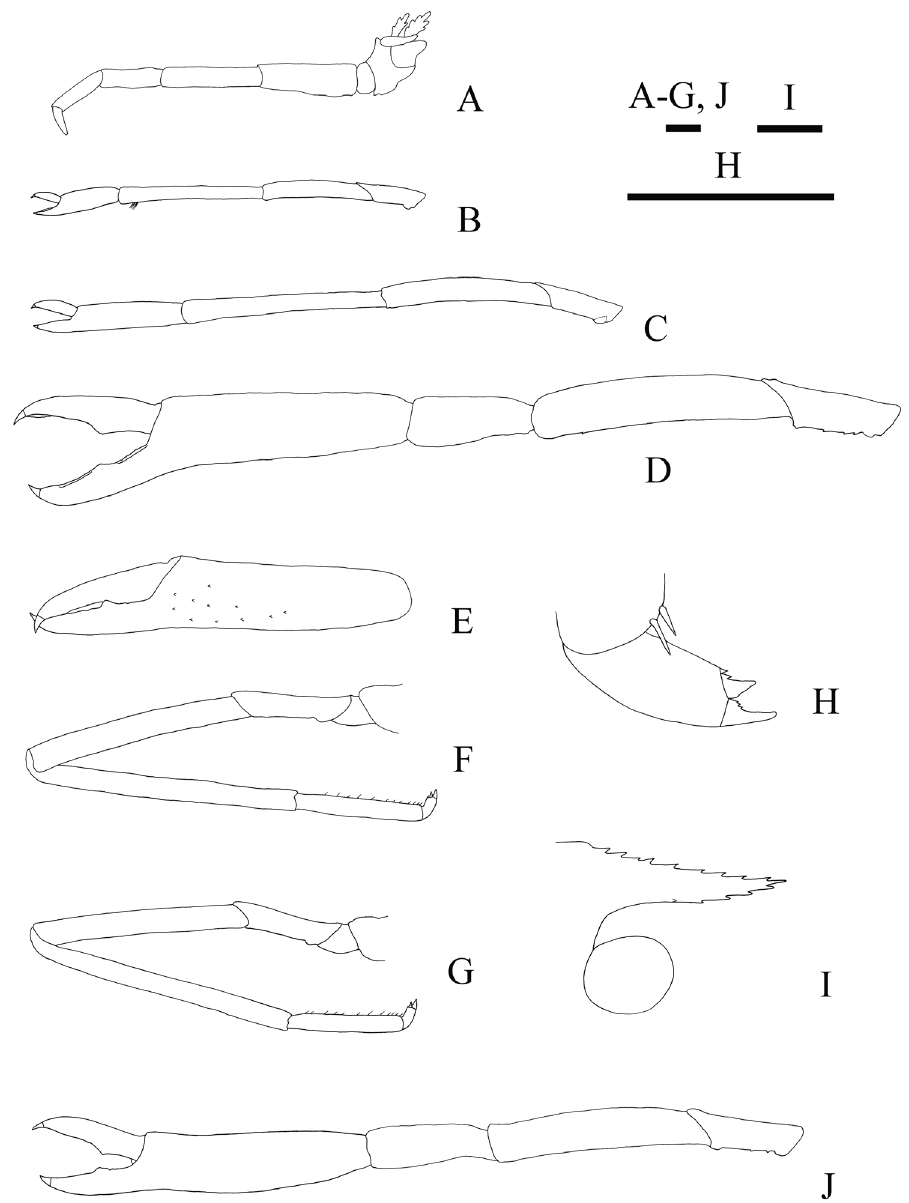
Figure 4. Spongicoloides weijiaensis sp. n. Holotype female: A left third maxilliped, lateral view B left first pereiopod, lateral view C left second pereiopod, lateral view D left third pereiopod, lateral view E flexor margin of right third pereiopod chela, lateral view F left fourth pereiopod, lateral view G left fifth pereio- pod, lateral view H dactylus of left fourth pereiopod, lateral view. Paratype male: I rostrum, lateral view J left third pereiopod, lateral view. Scale bars 1